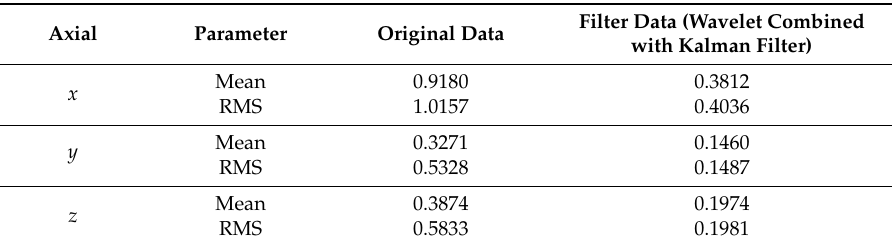
Table 1. Angular velocity errors of the SINS before and after filtering.